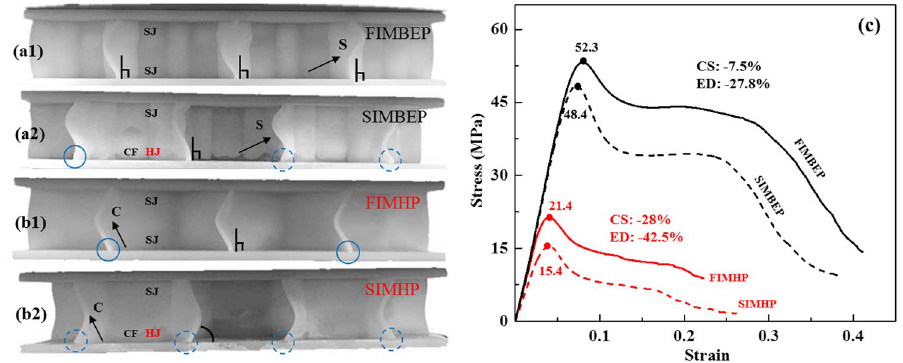
Figure 7. The experiment results on sandwich plates prepared using two different molding methods. ( a , b ) The deformation of the BEPs and HPs, respectively, at the end of stage II. ( c ) The strain-stress curves of the core structures. In this paper, FIMBEP and FIMHP denote sandwich plates produced using the full integrated method, whereas SIMBEP and SIMHP denote sandwich plates produced using the single integrated method. CF denotes a cement face; SJ denotes the solid joint; HJ denotes the hinge joint; CS denotes the compressive strength; ED denotes the energy dissipation. Dotted circles indicate instances of degumming or stripping between the honeycomb walls and the lower skin; vertical lines indicate right angles between the honeycomb walls and the lower skin; and solid circles indicate instances of intermediate deformation between the degumming case and the right-angle case, in which the core structure does not separate from the skins but not the honeycomb walls meet the skins at right